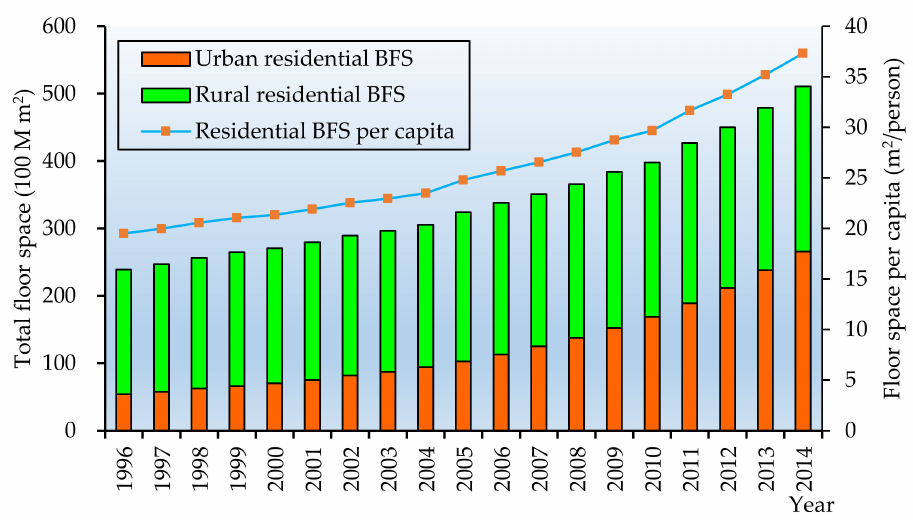
Figure 7. The residential BFS and per capita residential floor space (1996–2014).